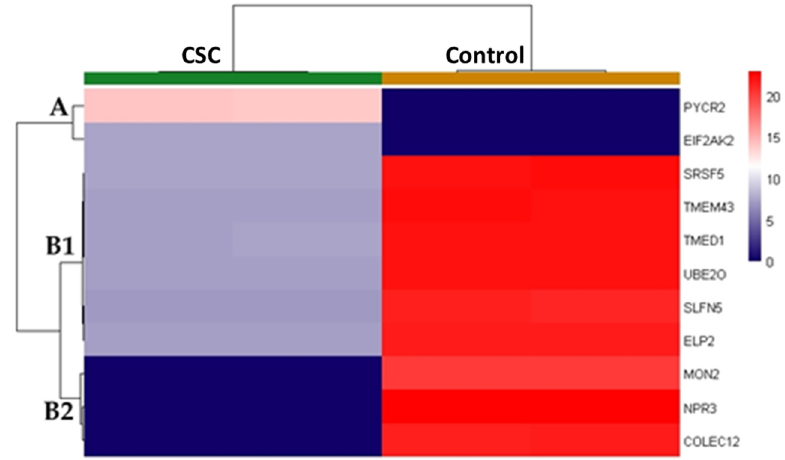
Figure 6. Heatmap of not-scaled Euclidean distances of abundance values from the 11 protein differences we identified between CSC-exposed (green bar in the horizontal dendrogram) and control (golden bar in the horizontal dendrogram) HSMCs by applying an MS-based shotgun proteomic approach.